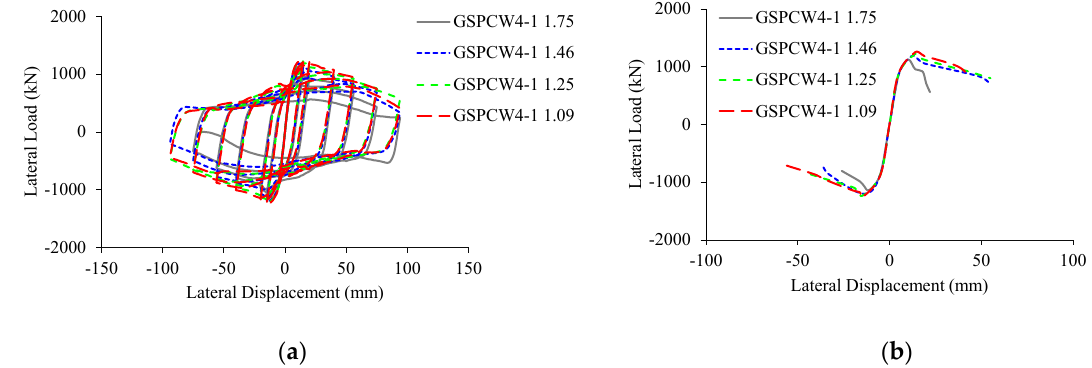
Figure 9. Influence of the aspect ratio of grille-type steel plate: ( a ) load–displacement hysteresis curves, and ( b ) skeleton